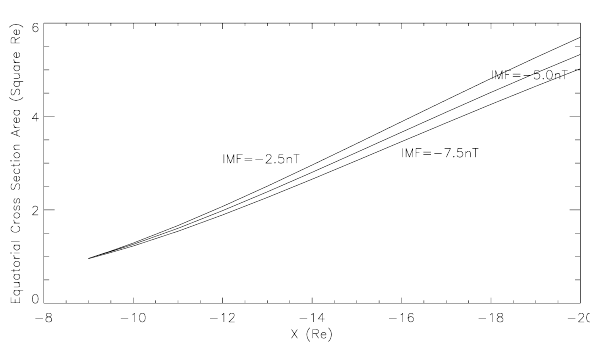
Fig. 9. Equatorial cross-section area of fast